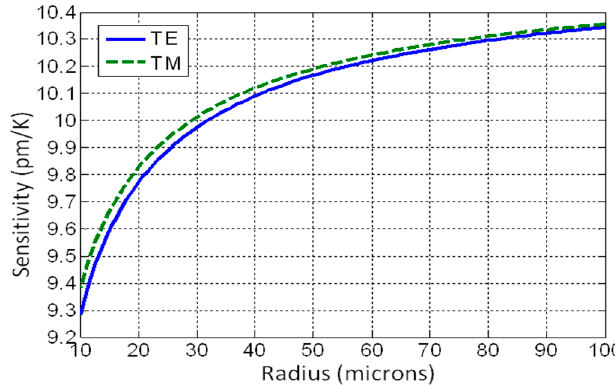
Figure 5. The transmission spectrum of the tapered fiber as a function of the wavelength for the temperatures 300, 200, and 400 K. r co = 30 μ m, L = 500 μ m, and ∆ r 0 = 3.8 nm .